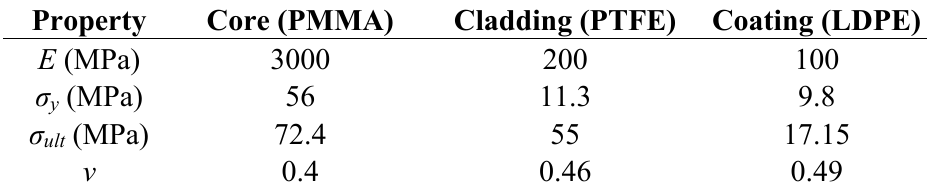
Table 1. Mechanical properties of POF materials